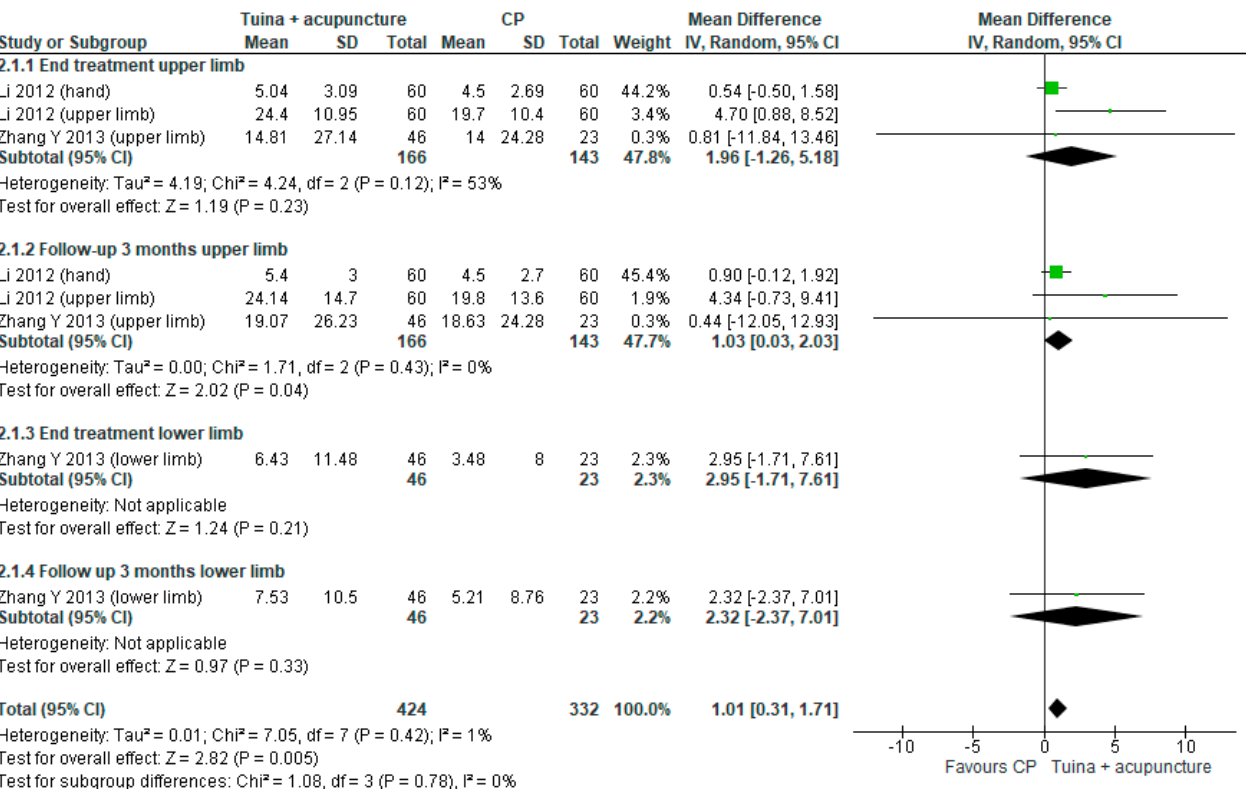
Figure 4. Forest plot of comparison Tuina massage plus acupuncture versus conventional physiotherapy (CP) for up- per/lower limbs motor function evaluated by Fugl Meyer Assessment Scale.